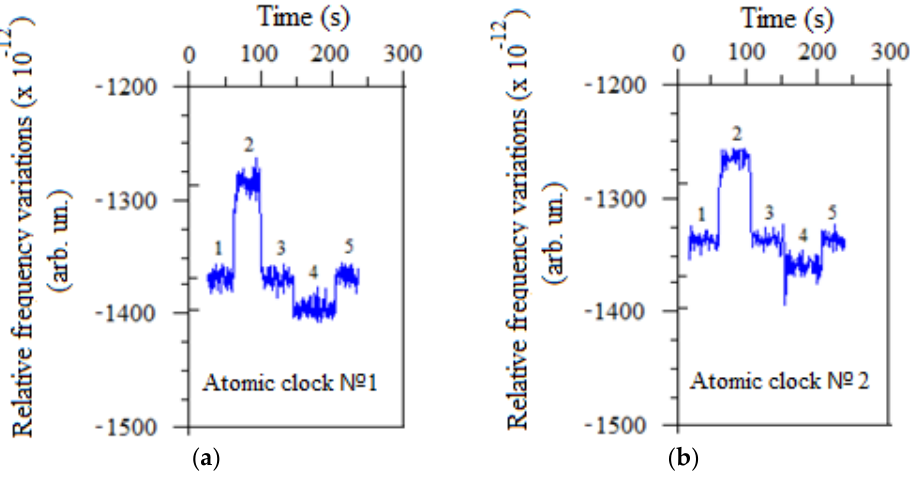
Figure 4. Recording of the atomic clock frequency variations in an external magnetic field created along their optical axis. Time sections 1, 2, 3, 4, and 5 correspond to the external magnetic field intensity H EXT equal to 0, +75 A/m, 0, -75 A/m, 0: ( a ) atomic clock no. 1; ( b ) atomic clock no. 2.